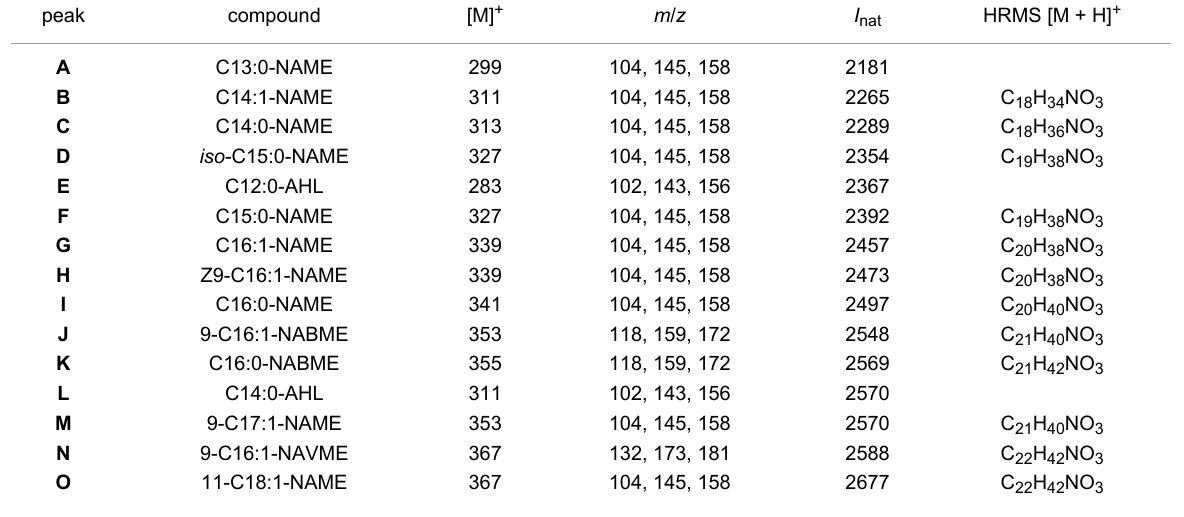
Table 1: Composition of the extracellular metabolites of Roseovarius sp. D12_1.68. [M] + , m/z : molecular and characteristic ions in EI mass spectrum.